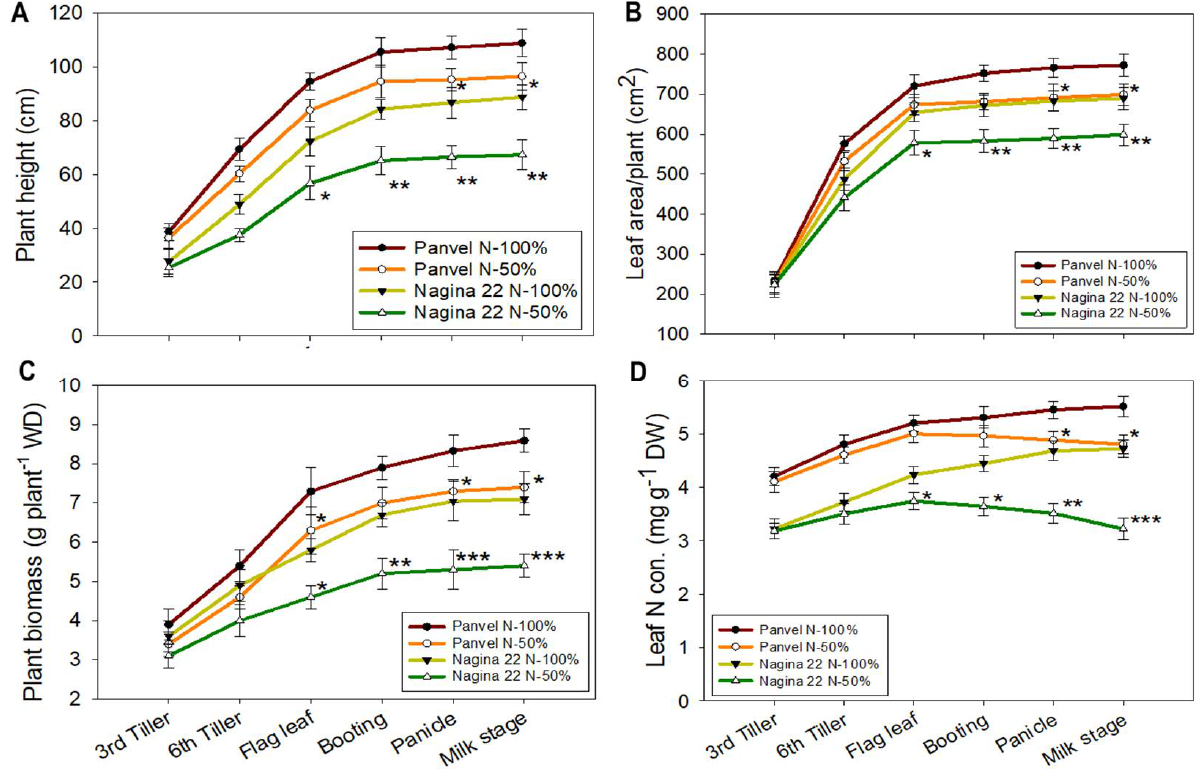
Figure 3. Variation in plant growth and nitrogen uptake of Panvel and Nagina 22 at six growth stages under N–50% and N–100% supply. Plant height ( A ), leaf area per plant ( B ), plant biomass ( C ), and leaf N content were measured in the dry shoot ( D ). Each curve in each graph represents the data set of mean ± SE of each treatment, and the asterisks denote the significant differences at * p < 0.05, ** p < 0.01, and *** p < 0.001 between treatments of each cultivar. 2.5. Rubisco Activity and Soluble Protein Differ between Panvel and Nagina 22